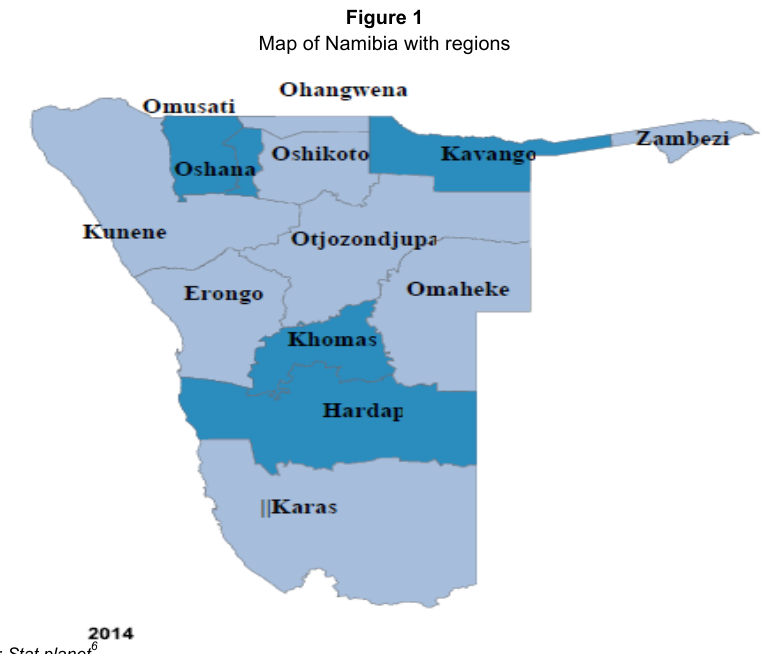
Map of Namibia with